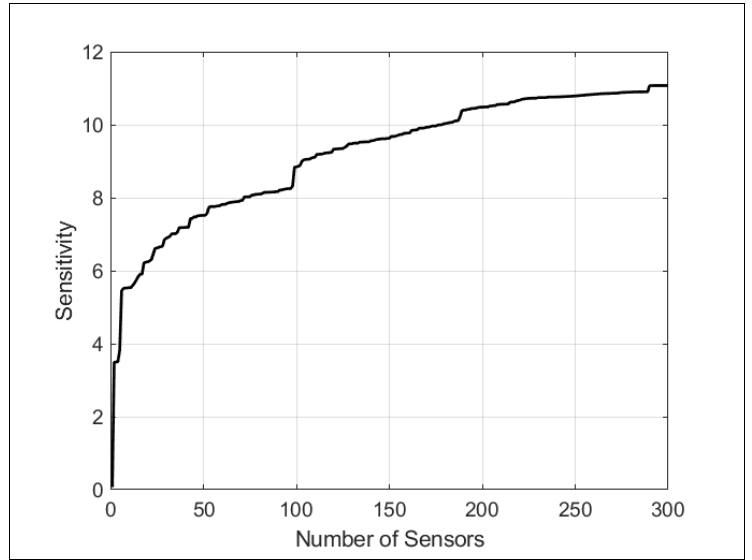
Figure 8. Sensitivity vs. number of sensors for the network under